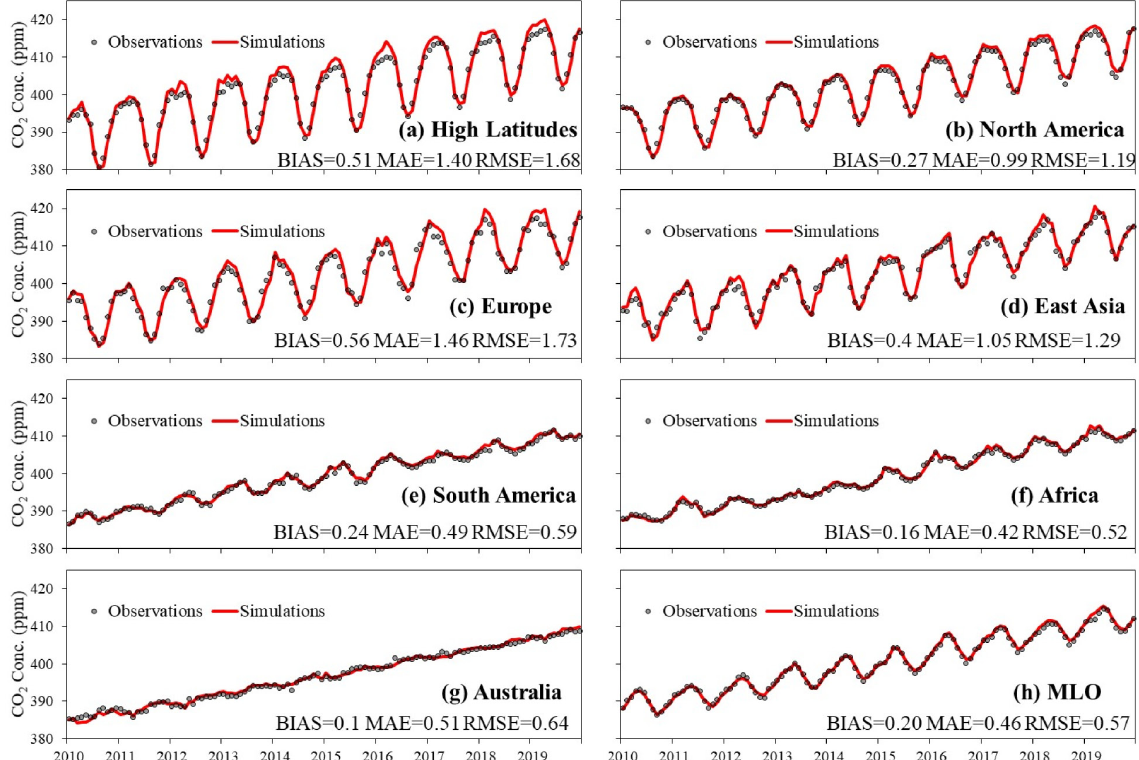
Figure 10. Time series of monthly averaged observations and simulations in the seven regions and at the MLO site.